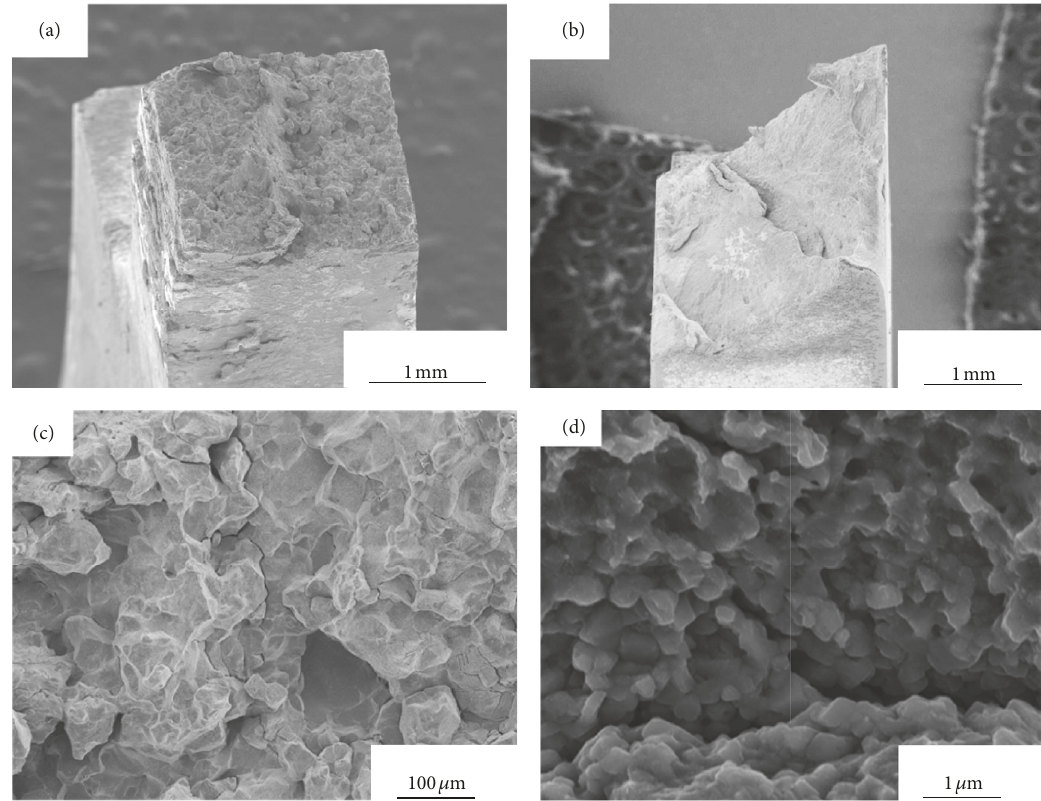
Figure 8: Fracture surfaces after SCC tests of (a), (c) sample 1, and (b), (d) sample 9 in (a), (b) macroscopic appearance, and (c), (d) microscopic